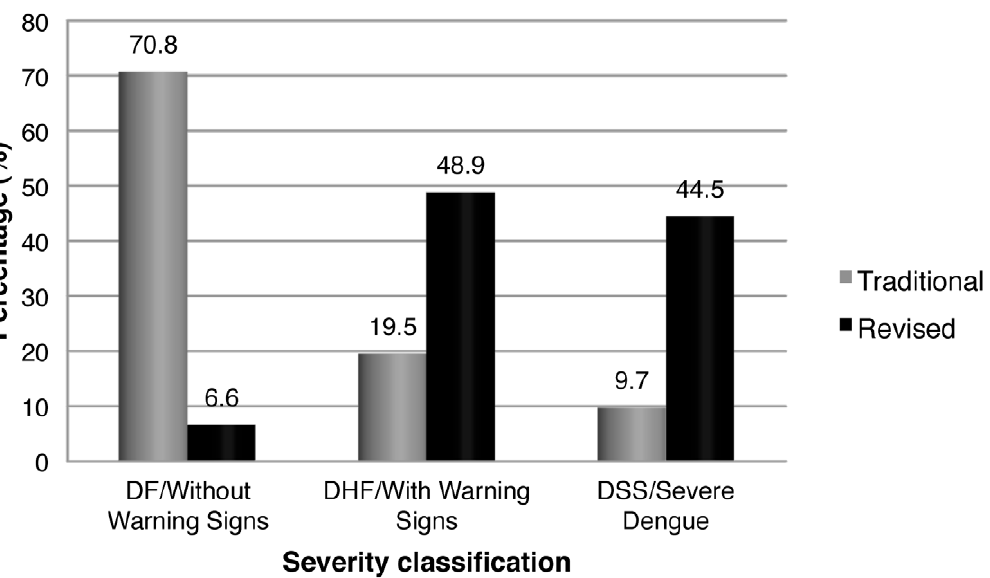
Figure 1. Traditional and revised WHO classification for dengue severity in Nicaraguan study, 2005–2010. The percentage of laboratory-confirmed dengue cases classified as DF (n=385), DHF (n=106), or DSS (n=53) in the traditional scheme or classified as Dengue without Warning Signs (n=36), Dengue with Warning Signs (n=266), or Severe Dengue (n=242) according to the revised scheme is shown.